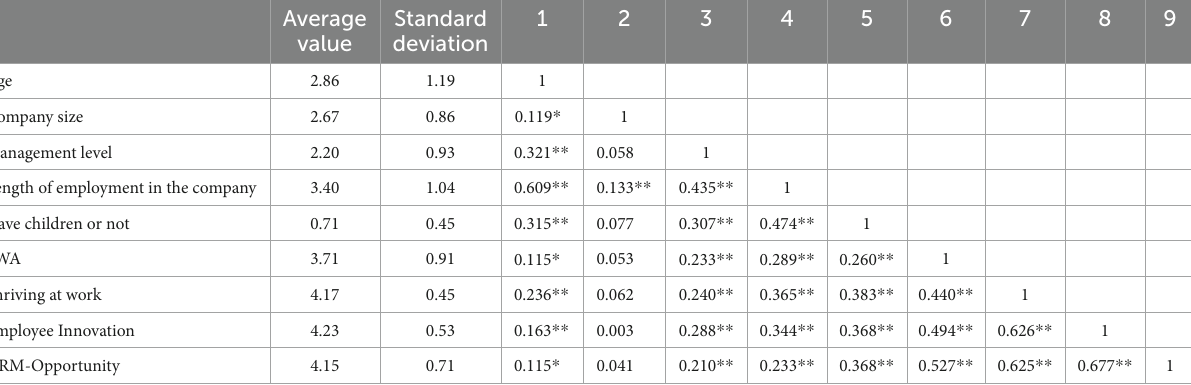
TABLE 2 Descriptive statistics and correlation analysis.